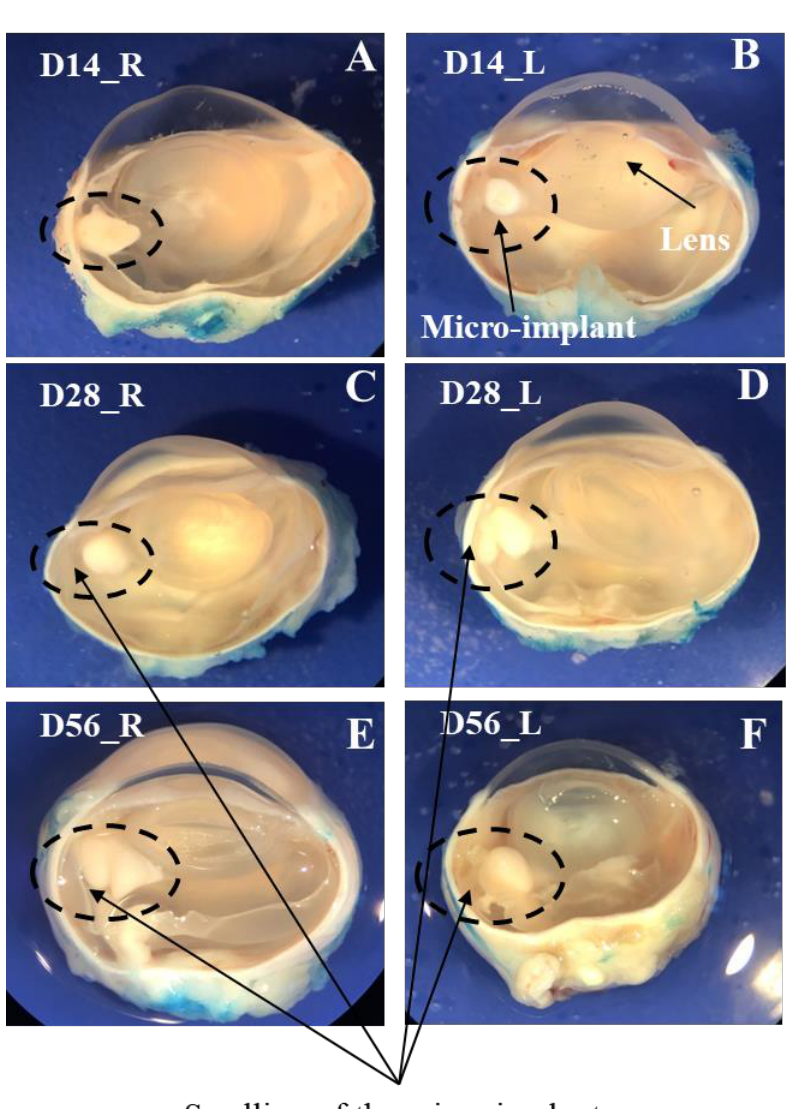
Figure 3. The position of the micro-implant relative to the lens can be seen in all the eye globes. The vitreous is clear in all the eye globes, indicating no toxicity caused by the MTX micro-implant and placebo micro-implant on the 14th day (( A , B ), respectively); on the 28th day (( C , D ), respectively); and on the 56th day (( E , F ), respectively). Note the swelling of the micro-implants on the Day 28 and Day 56 time-points. Nomenclature of the eye globes — Dxx_y, where xx = time-points (14, 28, 56), and y = eye (R — right eye receiving the MTX micro-implant; L — left eye receiving the placebo micro-implant).